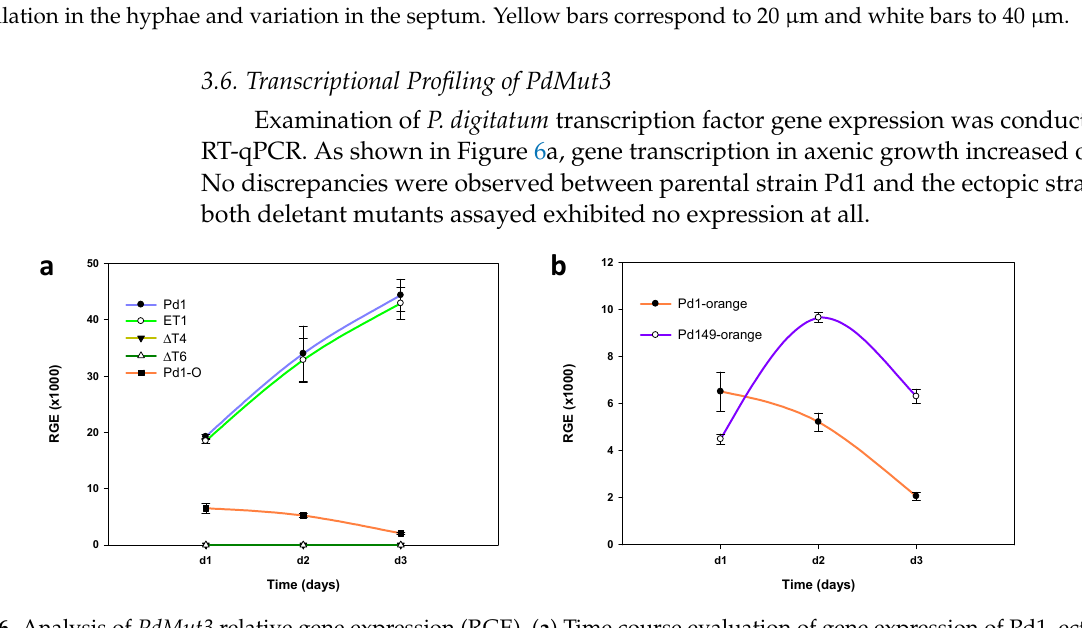
Figure 6. Analysis of PdMut3 relative gene expression (RGE). ( a ) Time course evaluation of gene expression of Pd1, ectopic mutant ET1, and deletant mutants ( Δ T4 and Δ T6) grown in PDB liquid culture at 25 °C and time course comparison of gene expression of Pd1 during orange infection. ( b ) Time course evaluation of gene expression of Pd1-virulent P. digitatum strain and Pd149-low virulent strain during orange infection. In all cases, d1, d2, and d3 correspond to 1 dpi, 2 dpi, and 3 dpi, respectively. The expression levels are relative to three reference genes: ribosomal 28S RNA, β -tubulin, and histone H3. Error bars indicate standard deviations of three biological replicates.